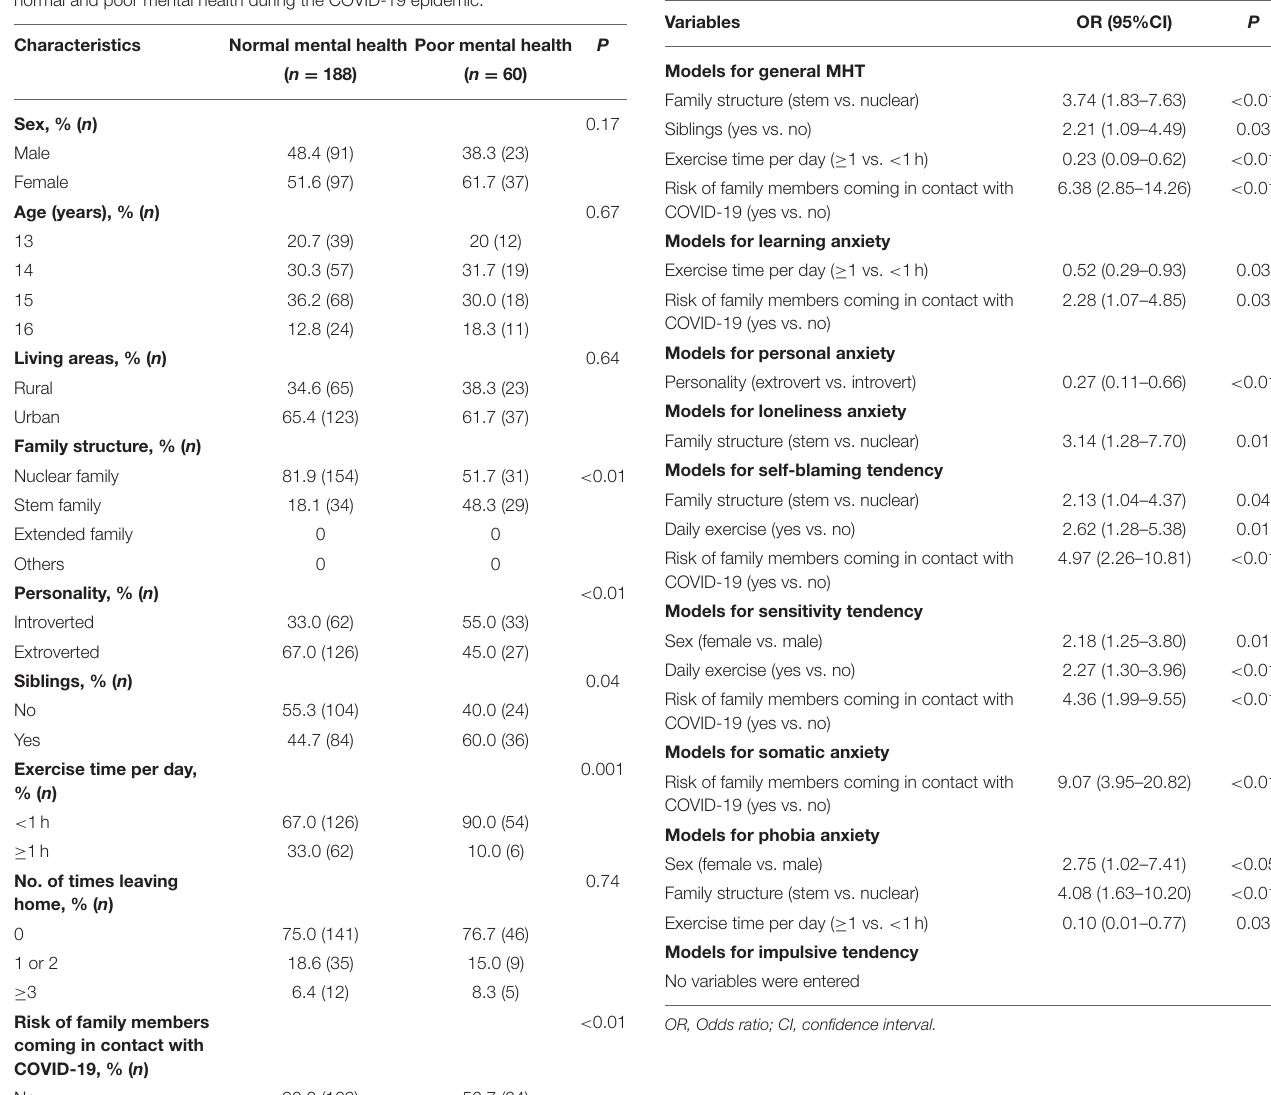
TABLE 3 | Outcomes of psychological manifestations.